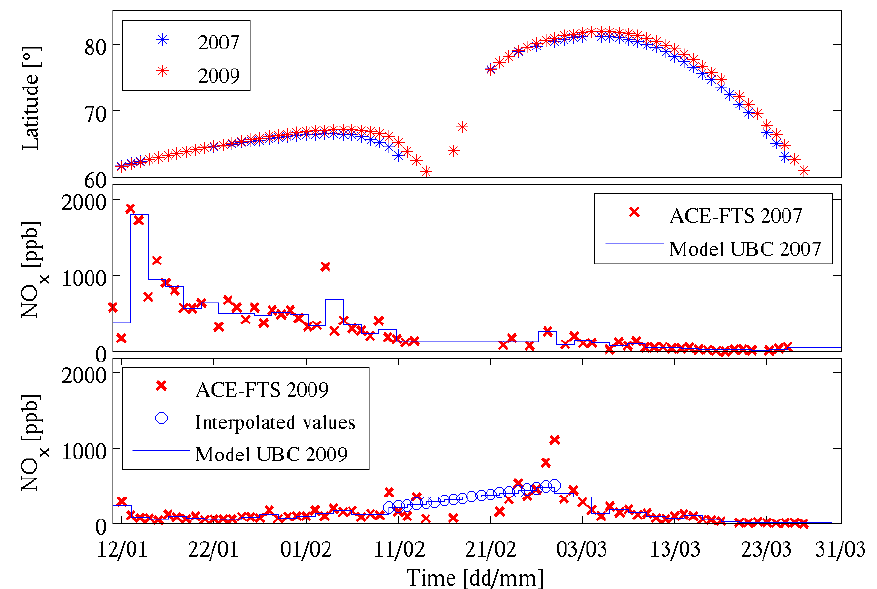
Fig. 1. Daily medians of ACE-FTS measurement locations north of 60 ◦ N (top) in 2007 (blue asterisk) and 2009 (red asterisk). The figure also shows mean NO x concentrations measured by ACE-FTS between 75–85km altitudes (red crosses) and two-day means calculated from the observations (blue line) for 2007 (middle) and 2009 (bottom). Two-day means for 2009 are based on interpolated values between 10 and 28 February (blue